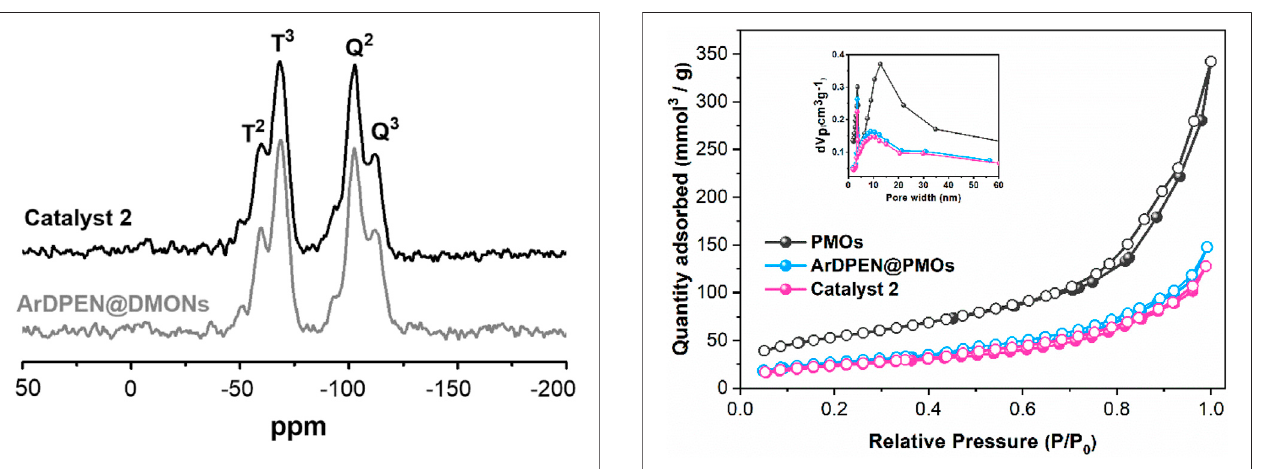
FIGURE2| Solid-state 29 SiCP/MASNMRspectraofArDPEN@DMONs and catalyst 2, *The rotation